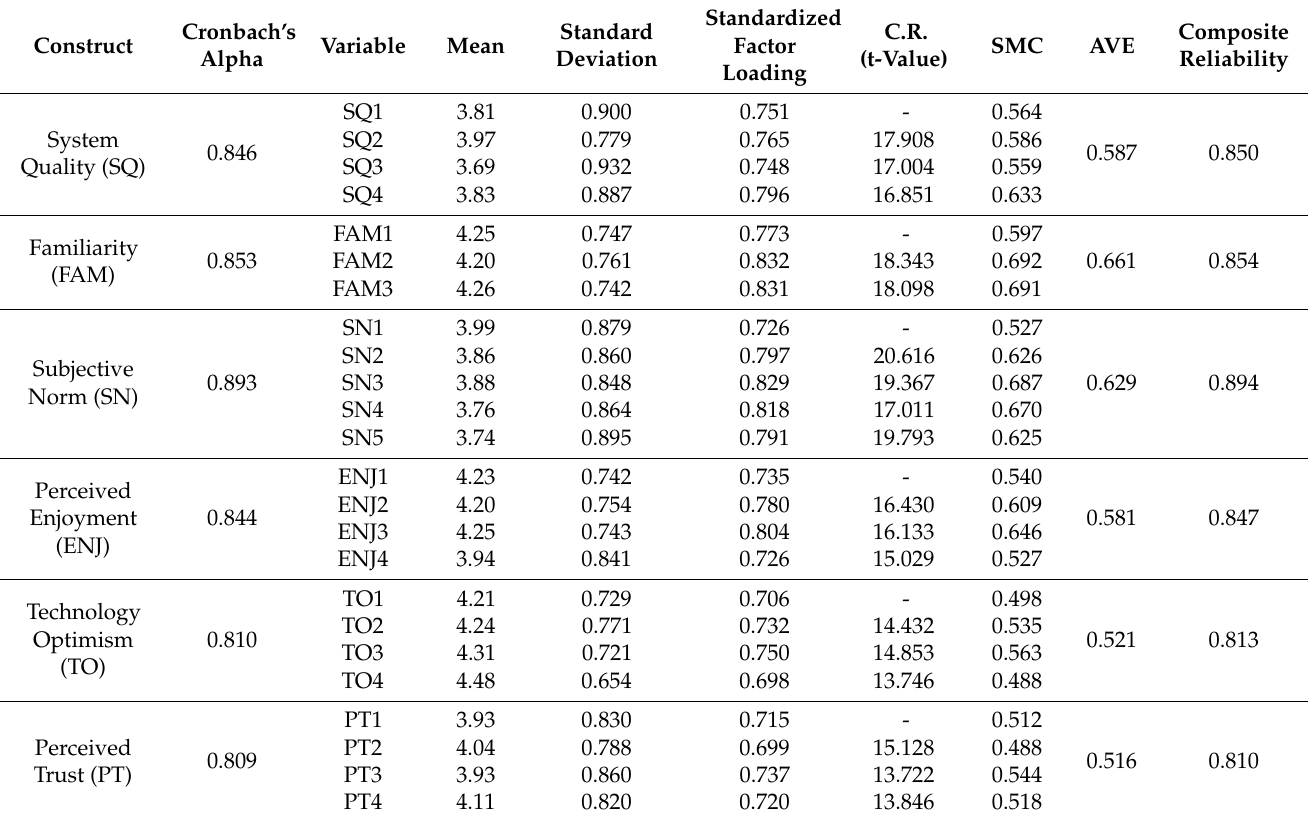
Table 3. Reliability and unidimensionality.